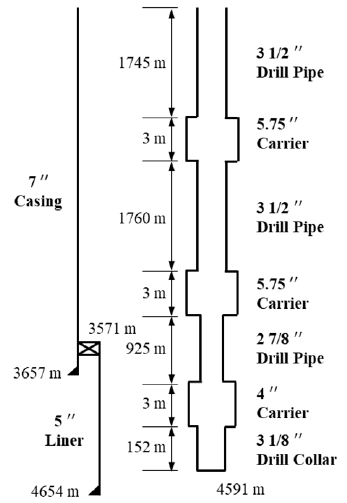
Figure 5. Wellbore-drill string geometries in Utah well.